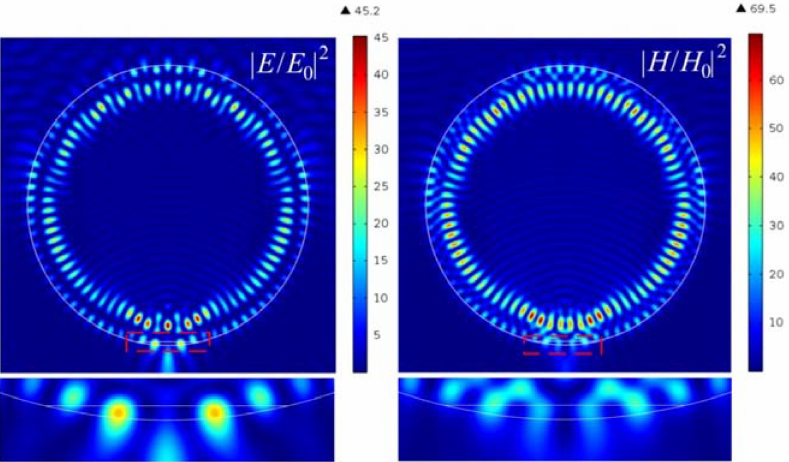
Figure 4. Hot-spot generation in cylindrical Janus particle with the parameters h = 68 nm and n = 1.1236 (water).